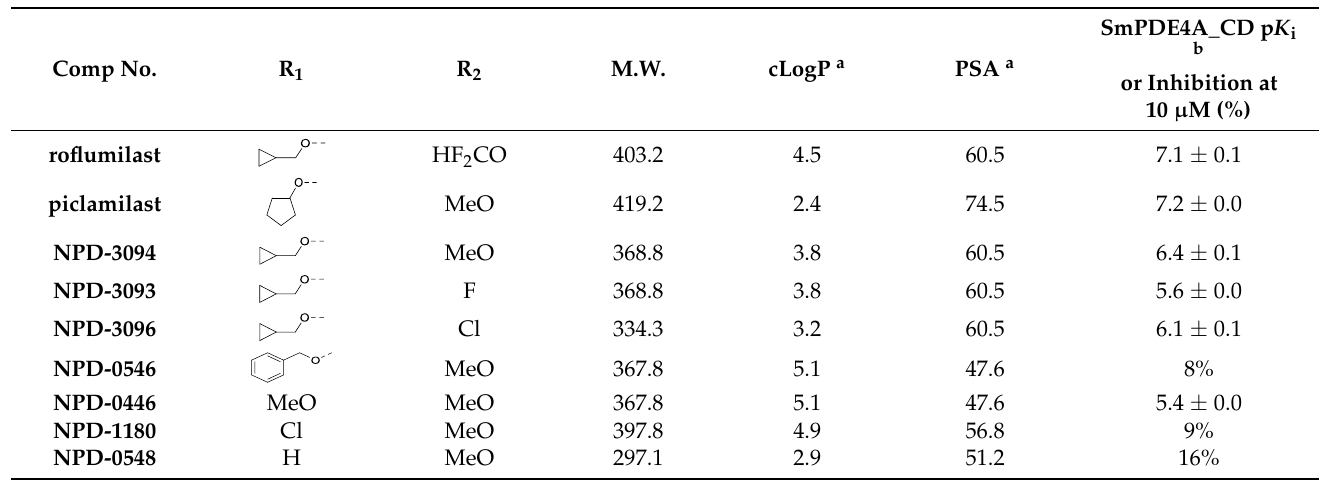
inhibitory potency, whereas removal of one chloride atom ( NPD-1205 ) resulted in only a three-fold reduction in potency. When both chloride atoms are removed ( NPD-3076 ), a strong reduction in PDE inhibitory potency is observed. A subsequent shift of the nitrogen atom from the 4-position to the 3-position was also not allowed. The replacement of the nitrogen atom in NPD-1204 by a carbon atom ( NPD-3080 ) results in a 10-fold reduction in potency. Any other modification results in a complete loss of SmPDE4A inhibitory po- tency (Table